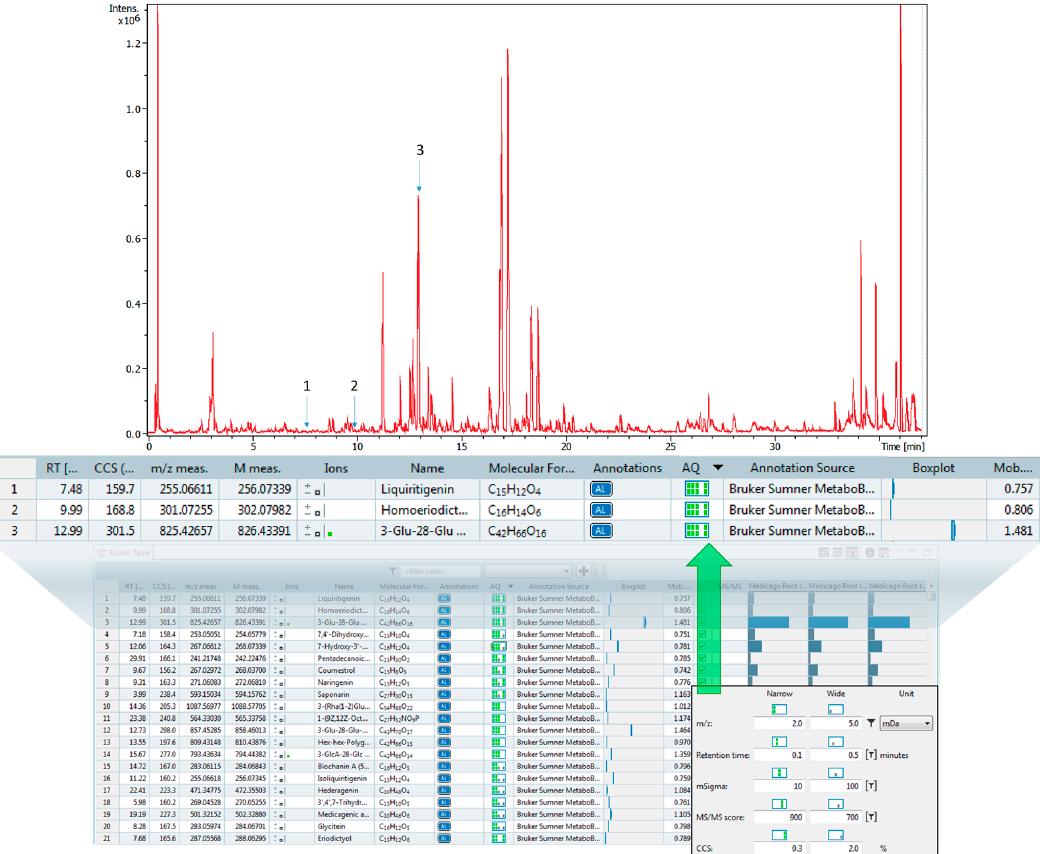
Figure 8. A representative matching report using Bruker MetaboScape software. The annotation quality (AQ) column shows a color coded matching confidence of each of the parameters used in the search (from left to right): accurate mass, retention time, isotopic pattern (mSigma), MS/MS fragmentation, and CCS. Each column has a set of customizable matching parameters. If the first matching criteria is met the square is grey, if the narrower criteria is met both squares are green. The CCS matching is a new orthogonal data feature that expands the confidence in metabolite identifications. The bottom square alone that is grey represents a matching of less than 5% variation between the library and the measured value. Both squares green represents a matching less than 2% variation between the library and the measured value.